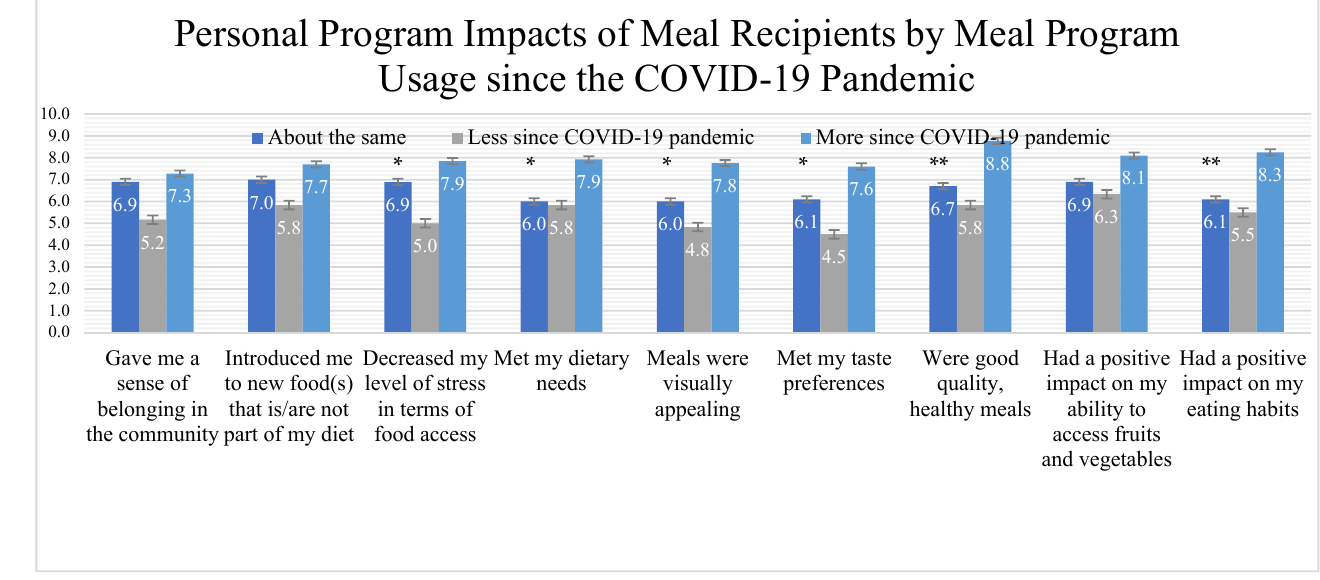
Figure 1. Likert Item Statements of Personal Impact of the Meal Service Program for Recipients. Data reported in means and standard error; * indicates p < 0.05 significant differences by utilization of meal services the since COVID-19 pandemic; ** indicates significance of p < 0.01.